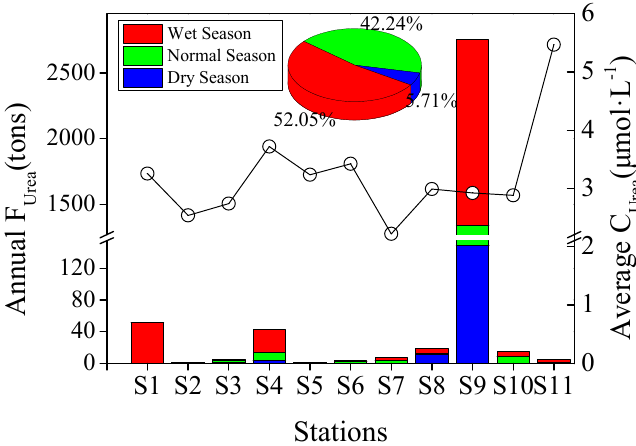
Figure 6. Annual urea variation flux input from the estuaries and sewage outlets of the ZJB.